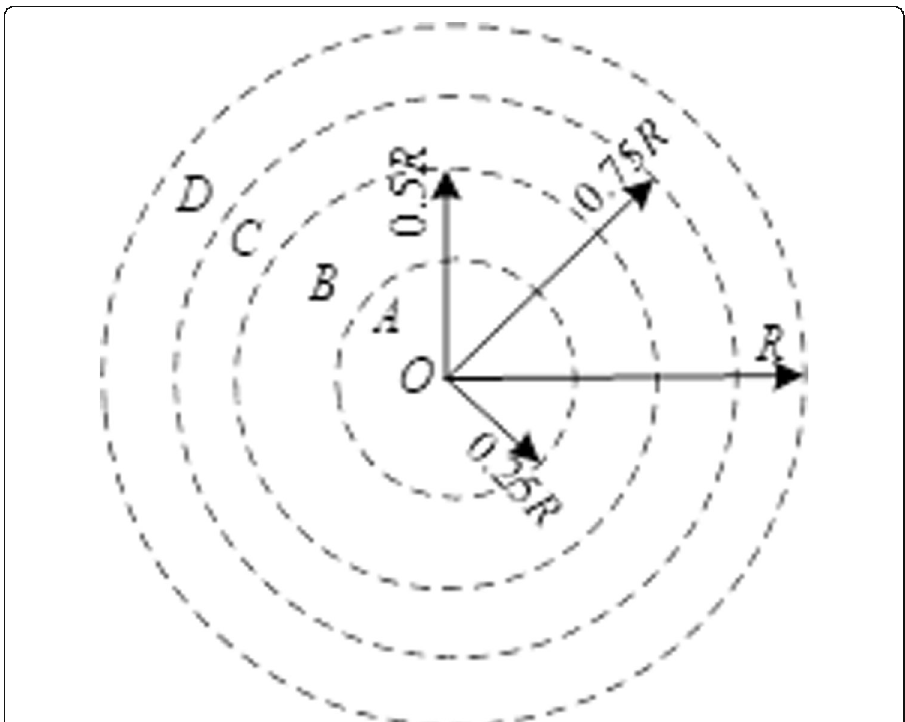
Fig. 4 Multiple communication